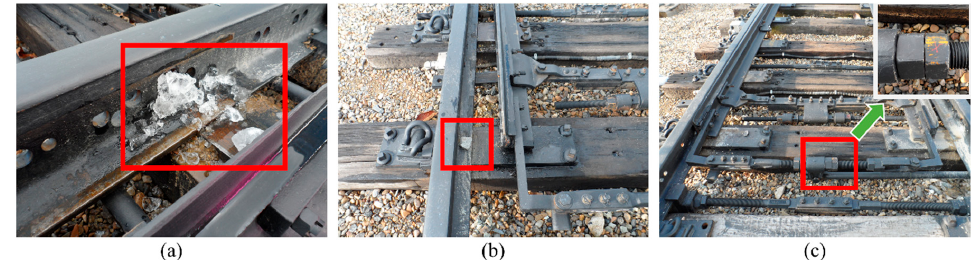
Figure 9. Data collection pictures from simulating three fault conditions: ( a ) ice obstruction; ( b ) ballast obstruction; and ( c ) slackened nut.